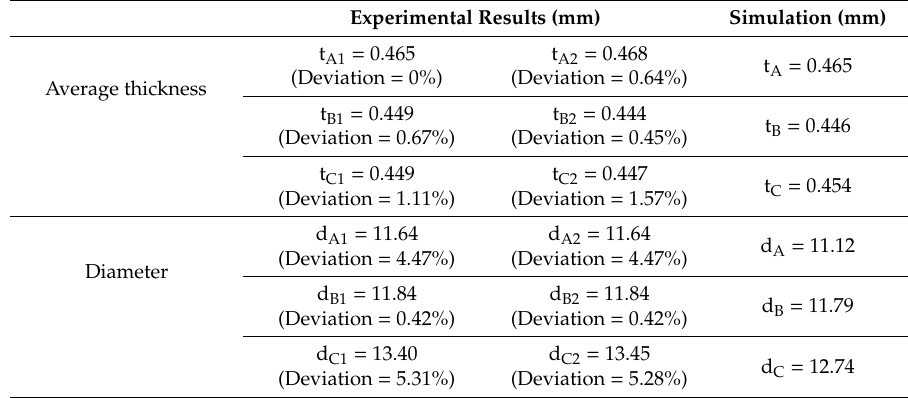
Table 3. Simulative and experimental thicknesses and diameters of formed product after stage